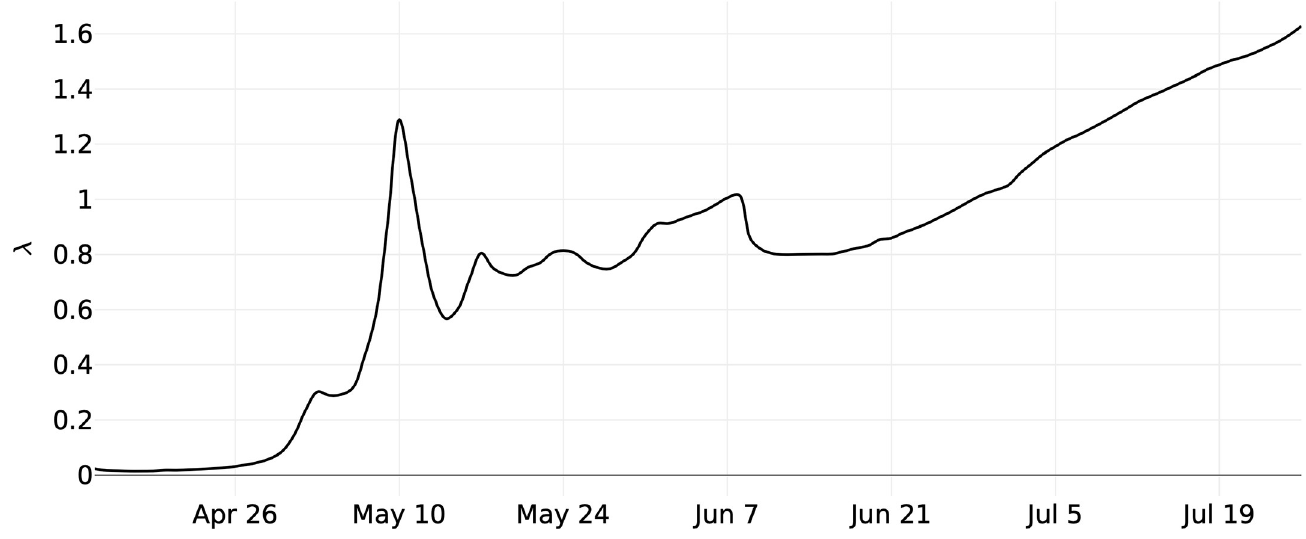
Fig 4. Prediction of the proportion of the population to attend to health care systems in Brazil.